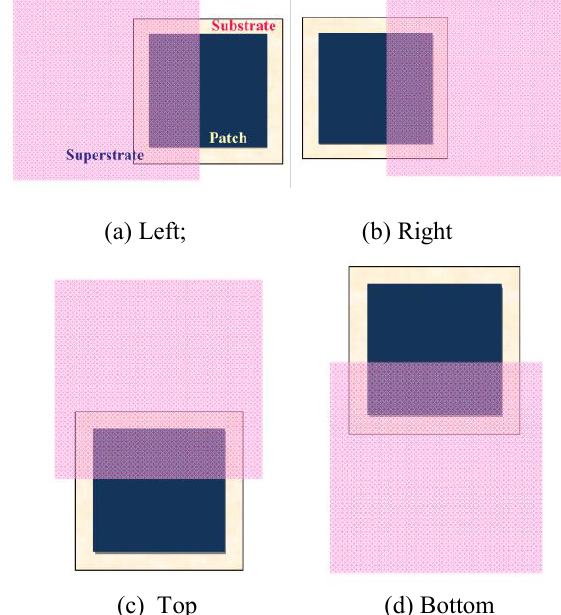
Figure 4. Manipulation of radiation pattern in different direction with superstrate at different